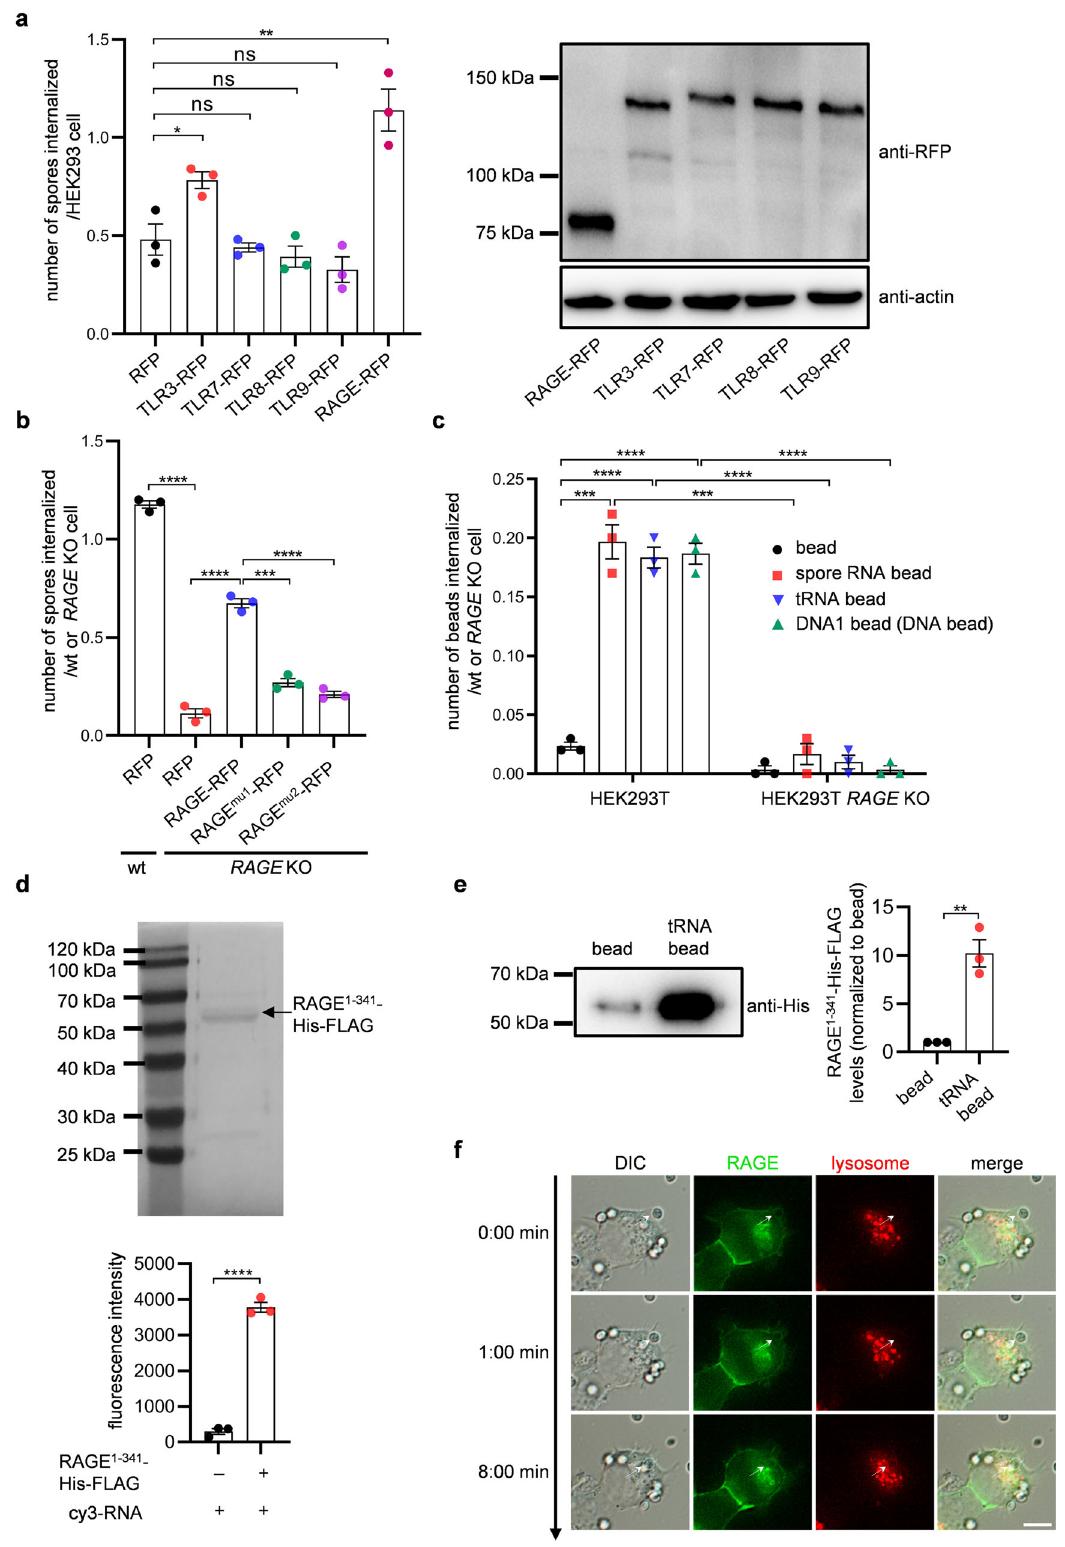
wall may contain other substance(s) that can augment or actively induce internalization. Regarding the latter possibility, a previous study showed that the RAGE-mediated in fl ammatory response is activated synergistically by DNA and HMGB1 35 . By analogy, we found that internalization of DNA- and HMGB1-bound (double- labeled) beads (DNA/HMGB1 beads) by HEK293T cells